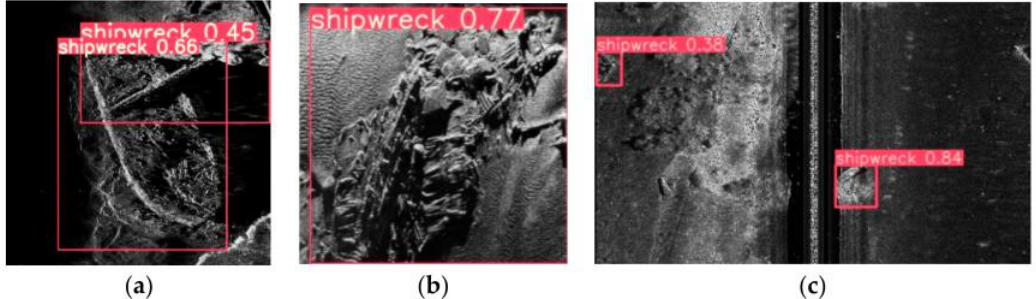
Figure 26. Detection results of targets in unbenign sections of the seabed: ( a ) shipwreck in a complicated environment; ( b ) eroded shipwreck in an area of sand ripples; ( c ) shipwreck in a high clutter